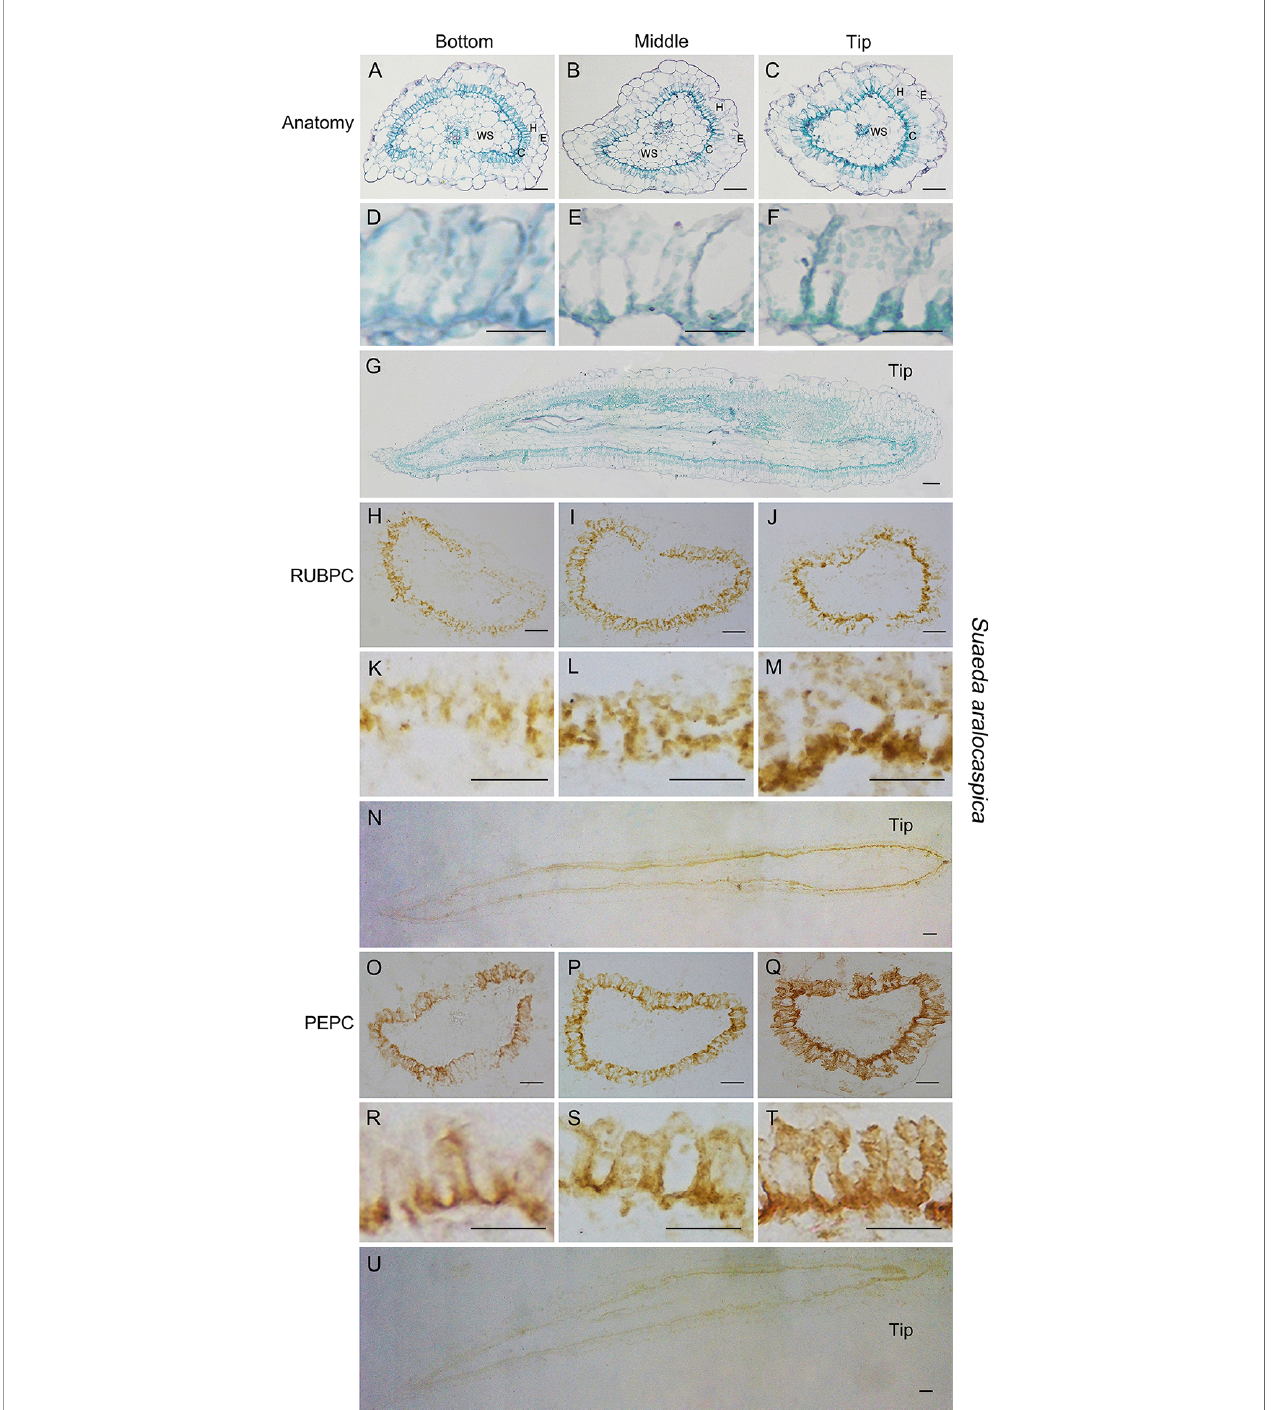
FIGURE 7 | Anatomic structure of leaf and in situ immune-histochemical localization (ISIHL) of RUBPC and PEPC in S. aralocaspica with transverse and longitudinal sections of young leaves (0.5 – 0.6 cm), showing a progressive development with gradual structure differentiation. (A – G) Anatomic structure of young leaf; (H – U) ISIHL results; (A – C) Transverse sections from the bottom to tip of leaf; (D – F) Detailed views corresponding to A – C; (G) Longitudinal sections of leaf; (H – J) ISIHL of RUBPC (RBCL) at the bottom, middle, and tip of leaf; (K – M) Detailed views corresponding to H – J; (N) ISIHL of RUBPC (RBCL) of longitudinal direction of leaf; (O – Q) ISIHL of PEPC at the bottom, middle, and tip of leaf; (R – T) Detailed views corresponding to O – Q; (U) ISIHL of PEPC of longitudinal direction of leaf. For LS structure of leaf, the tip is on the right. C, chlorenchyma; E, epidermis; H, hypodermis; WS, water storage. Scale bar in A – C, G – J, N – Q, U is 100 µm; in K – M, R – T is 50 µm; D – F is 25